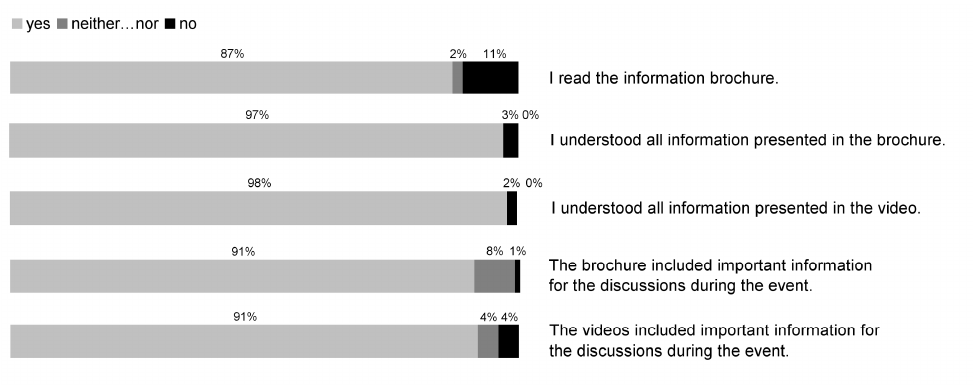
Figure 7. WWViews participants’ assessment concerning the usefulness of the information